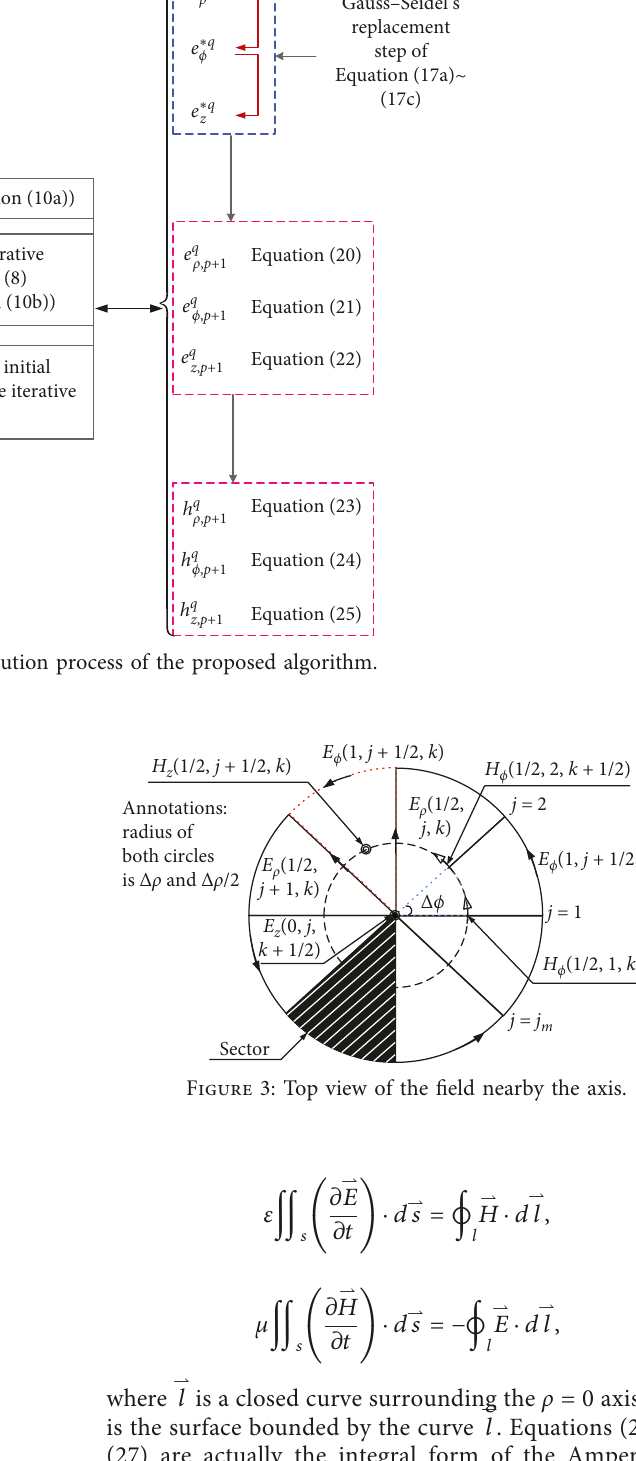
Figure 2: Position of field in cylindrical coordinates.